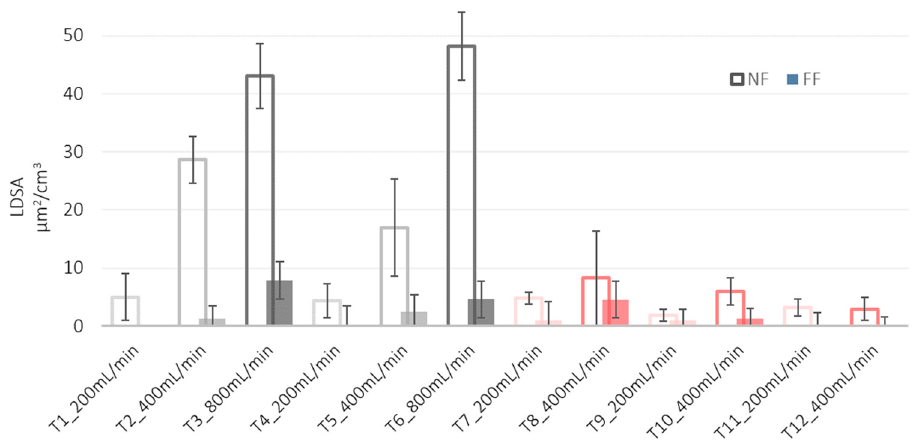
Figure 6. Histogram of LDSA of the particles emitted at the NF (empty bars) and FF (solid bars).